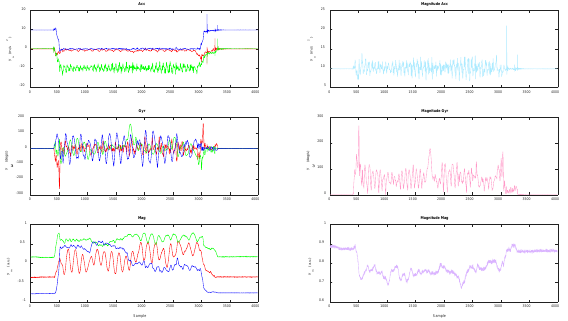
Figure 9: Input signal from the walking trial (with the IMU close to the wrist) that was used for in-use calibration. The red, green, and blue in the left column represents the x, y, and z components, respectively.